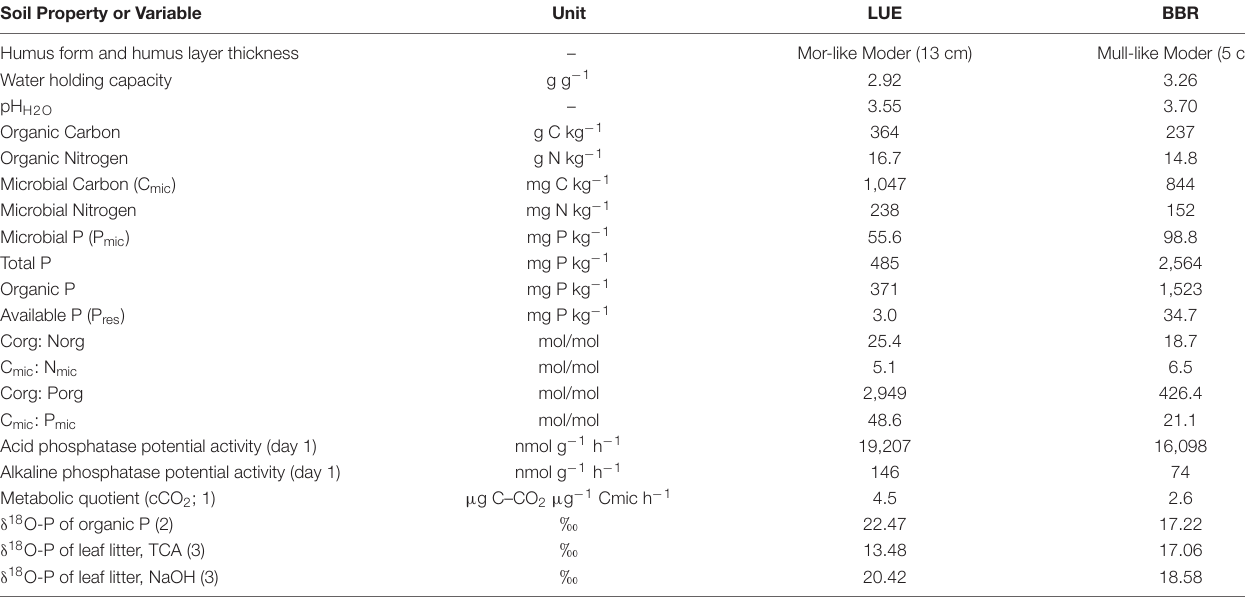
TABLE 1 | General characteristics of the two studied Oe horizons at site Lüss (LUE) and Bad Brückenau (BBR). Soil Property or Variable Unit LUE Humus form and humus layer